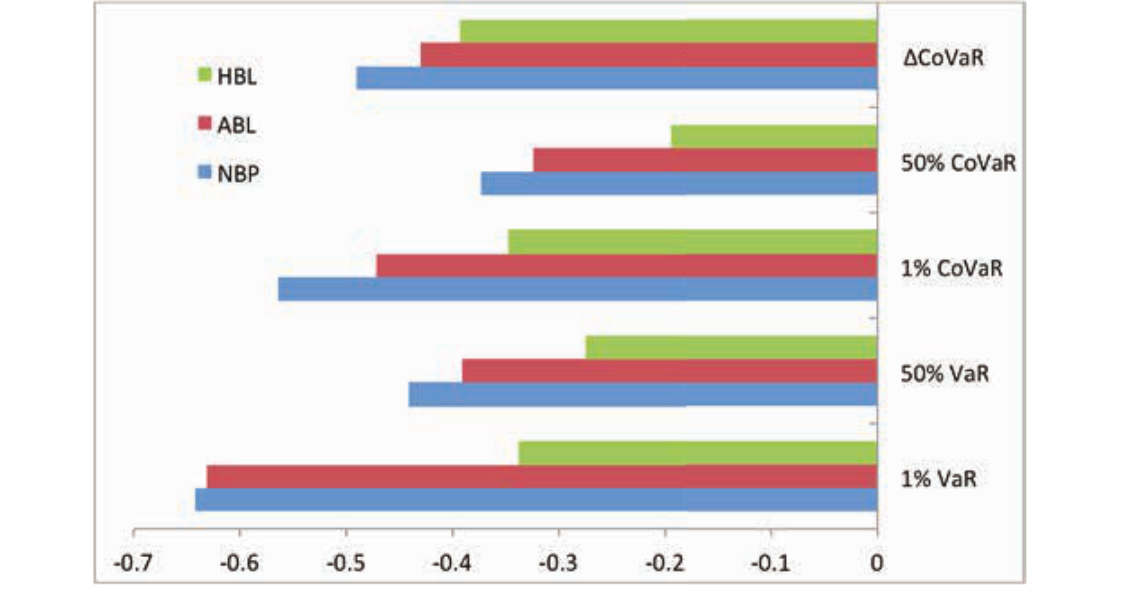
Figure 1: Estimated Risk Measures of Systemically Important Banks of